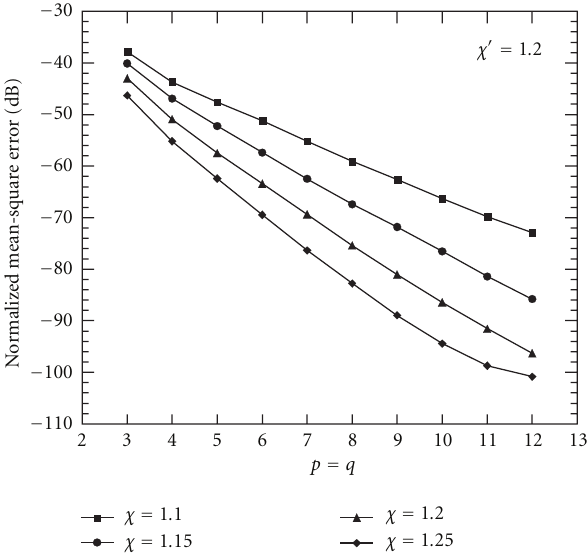
Figure 8: Mean-square reconstruction error of the probe voltage V